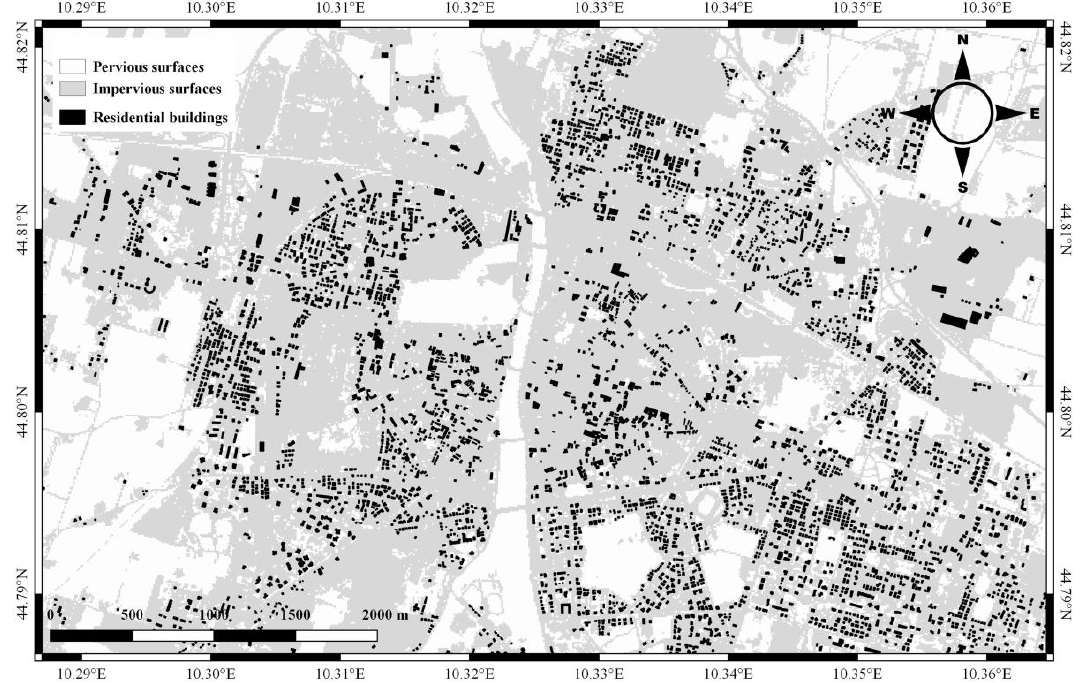
Figure 1. Map of residential buildings (black polygons) located in the city center of Parma. Impervious and pervious surfaces are indicated in grey and white, respectively.